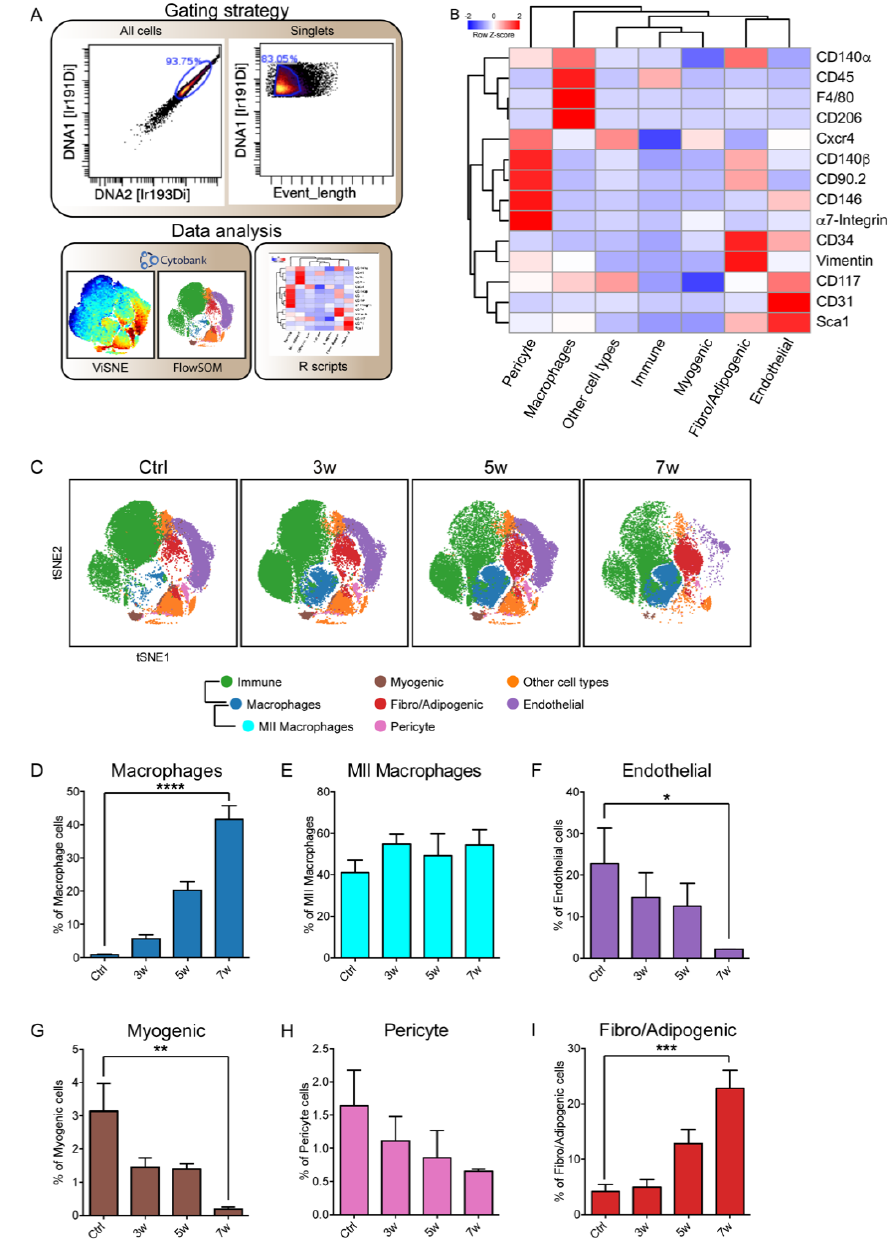
Figure 2. Mass cytometry analysis of skeletal muscle-cell subpopulations upon the induction of eRMS tumors in LSL-Kras G12D/+ ;Tp53 Fl/Fl mice. ( A ) Workflow of the gating strategy. Cells were manually gated from debris on the basis of DNA content monitored by the incorporation of the Ir intercalator. Doublets were then excluded according to the event-length parameter. Manually gated singlet events were used for tSNE and FlowSOM analysis in Cytobank. ( B ) FlowSOM heatmap of column-normalized (z-score) marker expression for each of the identified clusters. Colors varied according to the expression level of the considered marker in a blue-to-red scale, indicating low to high expression, respectively. ( C ) Time course of the variation in muscle-cell subpopulation abundance upon Ad-Cre infection. The dynamic changes are illustrated by representative density plots generated with FlowSOM algorithm. ( D – I ) The bar plots quantitate the variation in population relative abundance evaluated three, five and seven weeks after Ad-Cre hind-limb infection and compared with Ctrl mice. With the exception of the MII macrophage number determined on the total number of macrophages, cell percentages were assessed on the total number of cells in each sample ( n = 3). The statistical significance was estimated by one-way ANOVA. All data are represented as mean ± SEM, and the statistical significance was defined as * p < 0.05; ** p < 0.01; *** p < 0.001; **** p < 0.0001.